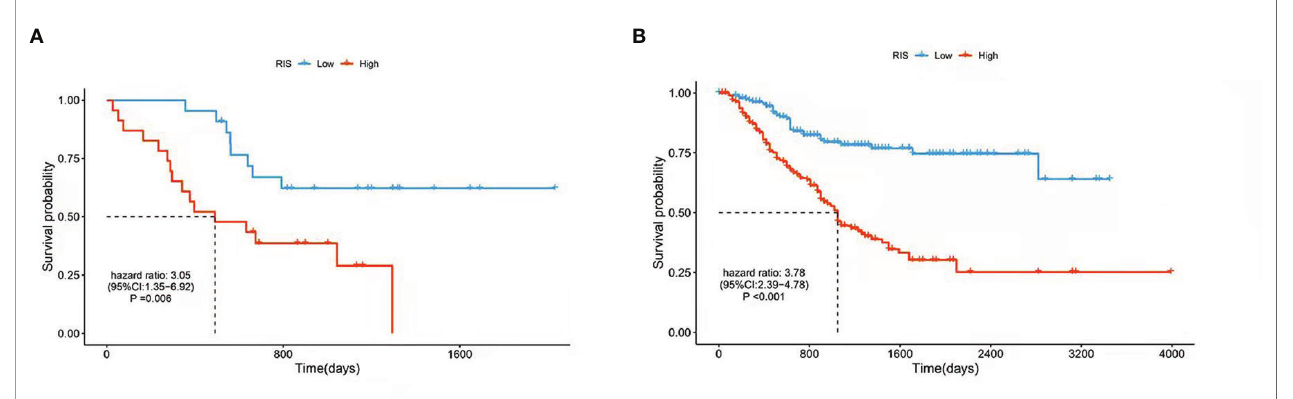
FIGURE 3 | Kaplan – Meier estimates of the patients ’ survival using the radiomics score. The Kaplan – Meier plots were used to visualize the patients ’ survival probabilities for the low-RIS versus high-RIS group of patients based on the median radiomics score. (A) Kaplan – Meier curves for TCGA database patients (N = 45). (B) Kaplan – Meier curves for patients from Nanfang Hospital database (N = 392). The differences between the two curves were determined by the two-side log-rank